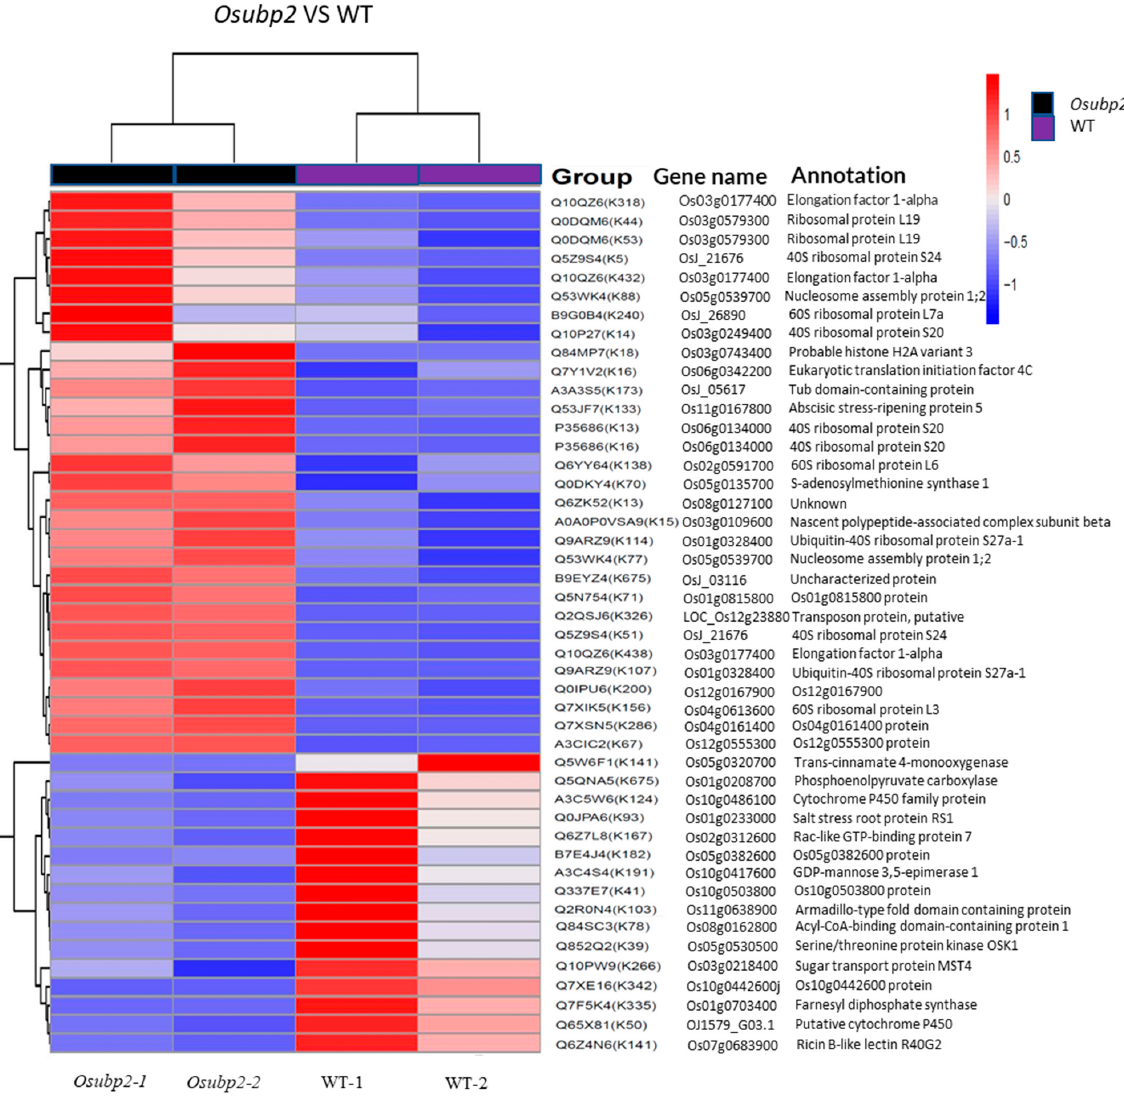
Figure 8. Proteomics analysis of the Osubp2 and WT plants. Clustering result of modified sites with significant differences between the Osubp2 and WT. WT − 1 and WT-2, Osubp2 − 1, Osubp − 2 represent two replicates. Annotation on the right side contains group (protein ID + modification site) gene name and the annotation of the gene. The information of protein ID, gene name, and the annotation of the gene was from UniProt (https://www.uniprot.org/ (20 August 2022)). Red represents higher ubiquitination modification, and blue, lower ubiquitination modification.